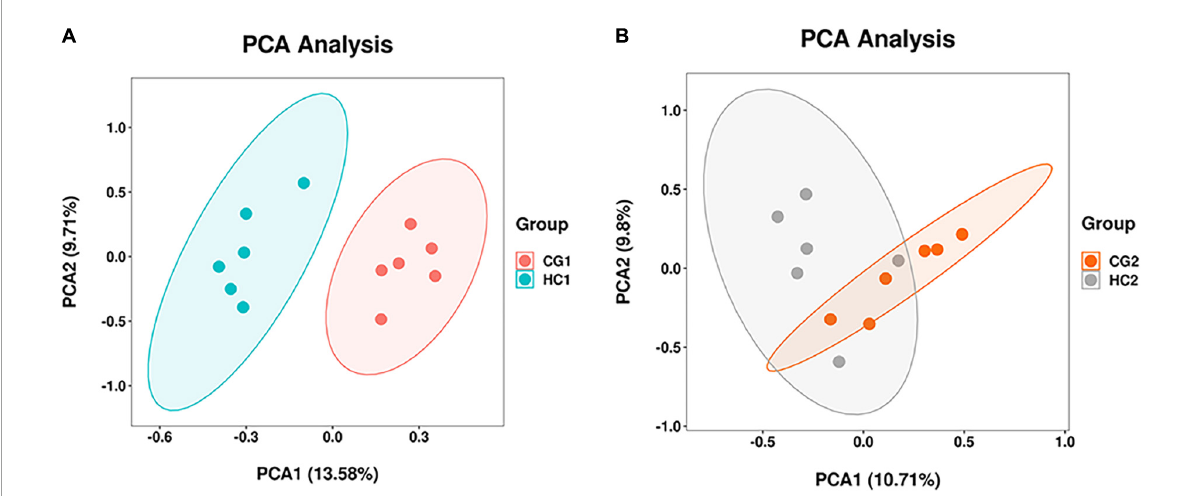
FIGURE2 PCA of cecal microbiota at 53 (A) and 67 (B) days of age. CG1, control group at 53 days of age; CG2, control group at 67 days of age; HC1, the high dose at 53 days of age; HC2, the high dose at 67 days of age.